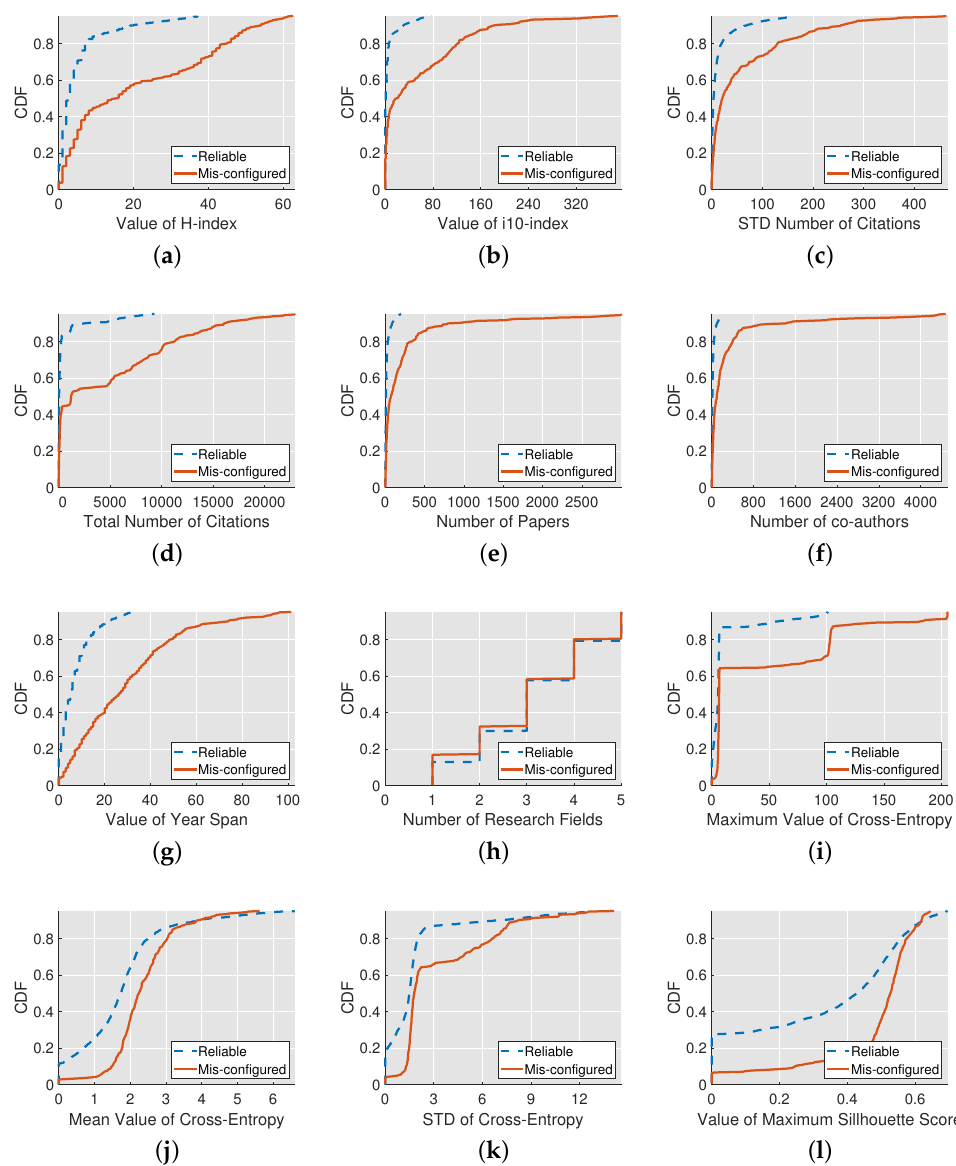
Figure 1. Comparison between reliable author profiles and mis-configured author profiles on different features. ( a – l ) show the comparison on features in Table 1 (except Verified, which is a two-value feature),